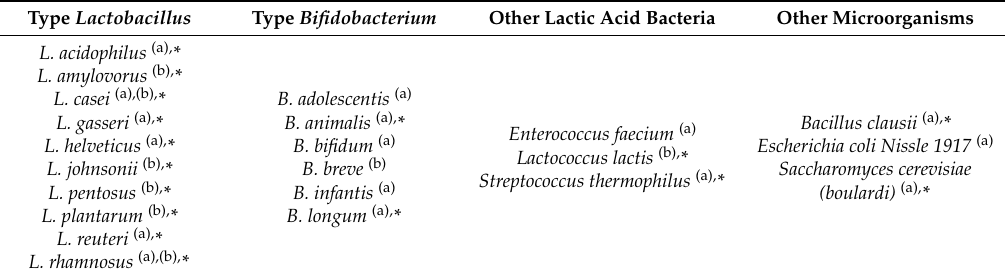
Table 2. Probiotic microorganisms used in human nutrition